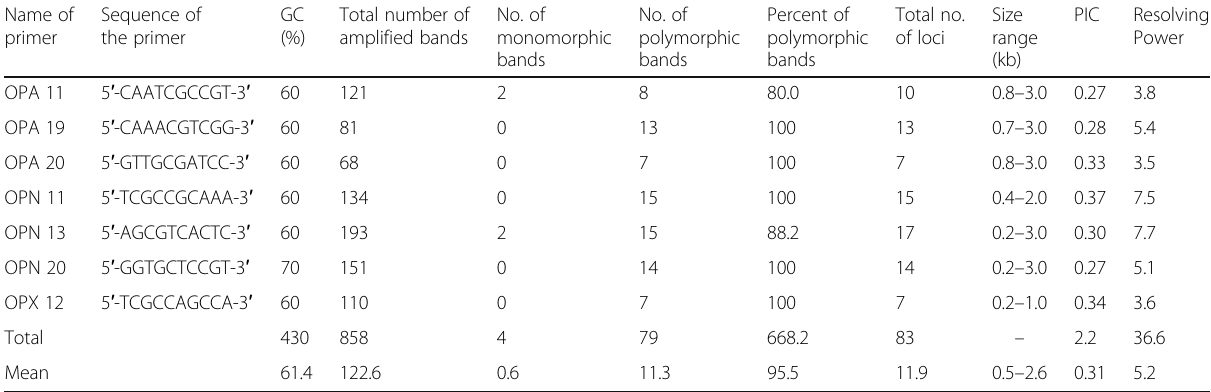
Table 3 PCR details of 30 clumps of the three growth forms/sampling locations of D. strictus